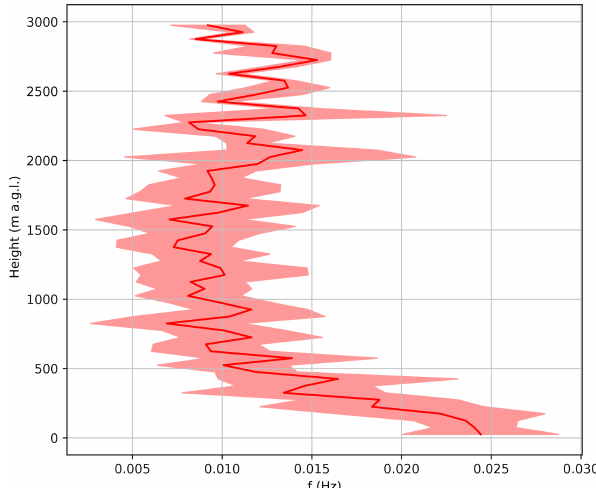
Figure 2. Mean and standard deviation profile of Brunt–Väisälä fre- quencies for all late-night flights. The mean value within the stable boundary layers is 0.023s − 1 .